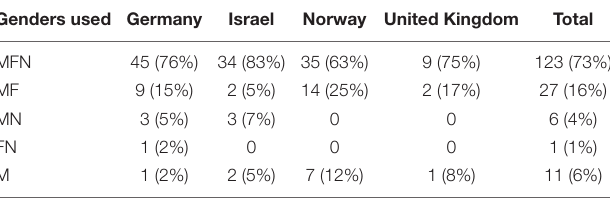
TABLE 4 | Individual profiles with nonce-words, N